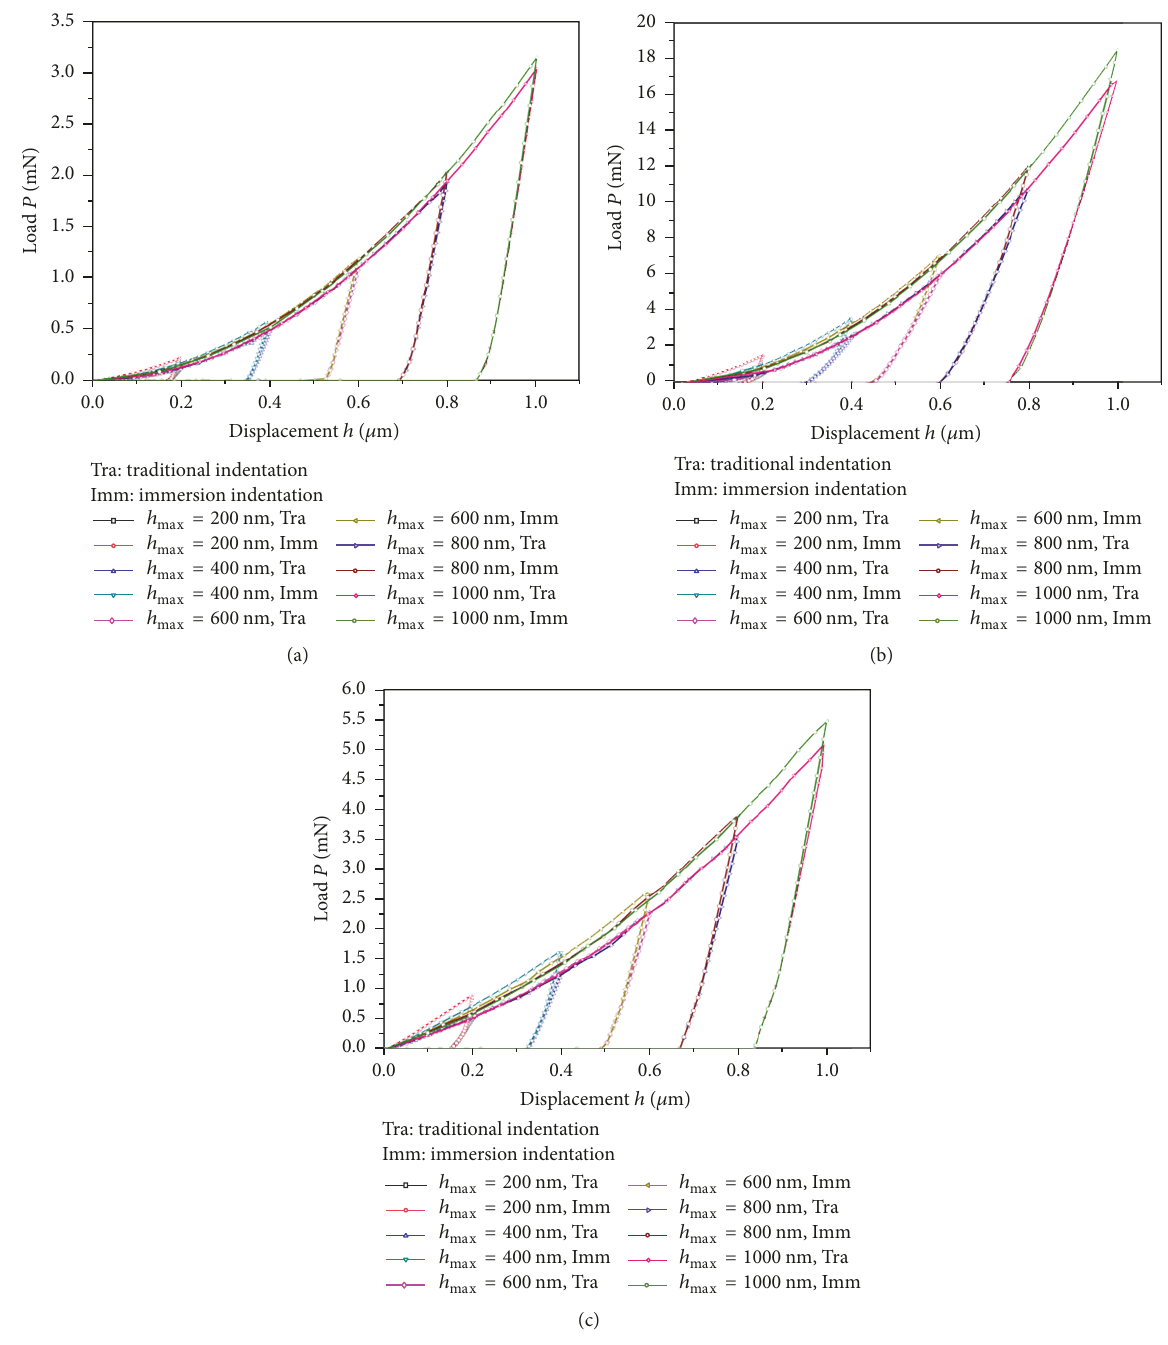
Figure 3: Load-displacement curves of immersion indentation and traditional indentation with different indenters, (a) cubic indenter, (b) Berkovich indenter, and (c) spherical